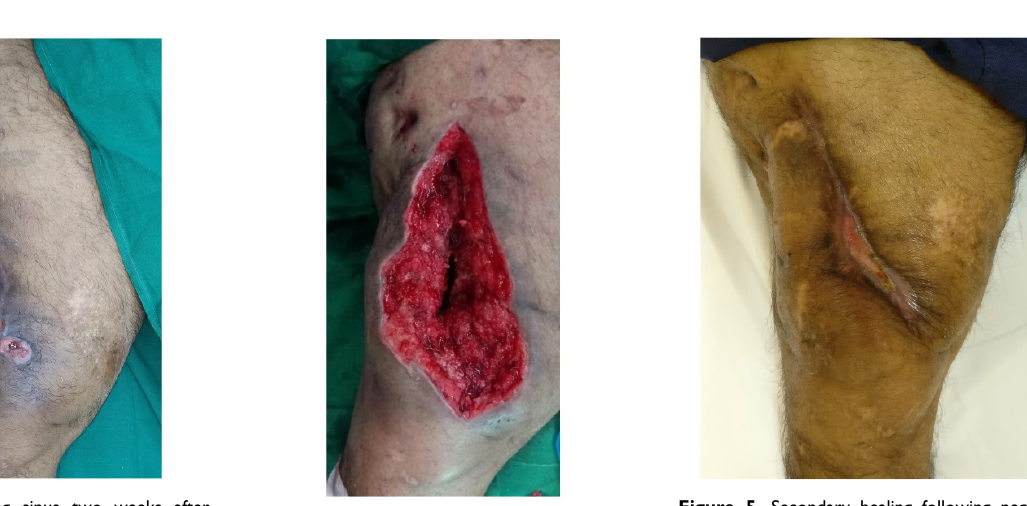
Figure 3 . Discharging sinus two weeks after debridement